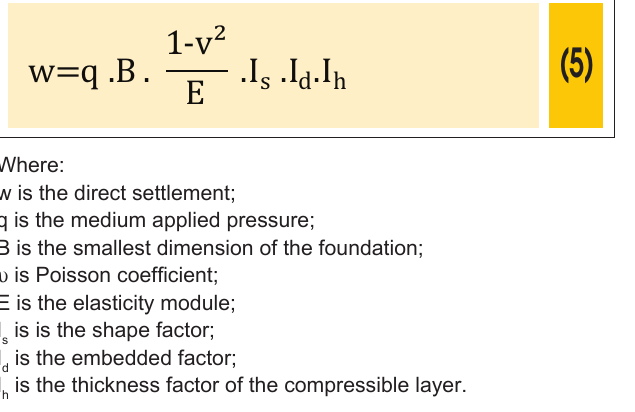
Table 3.3 – Shape factors Is, for loadings on the surface in an infinite thickness way [12]